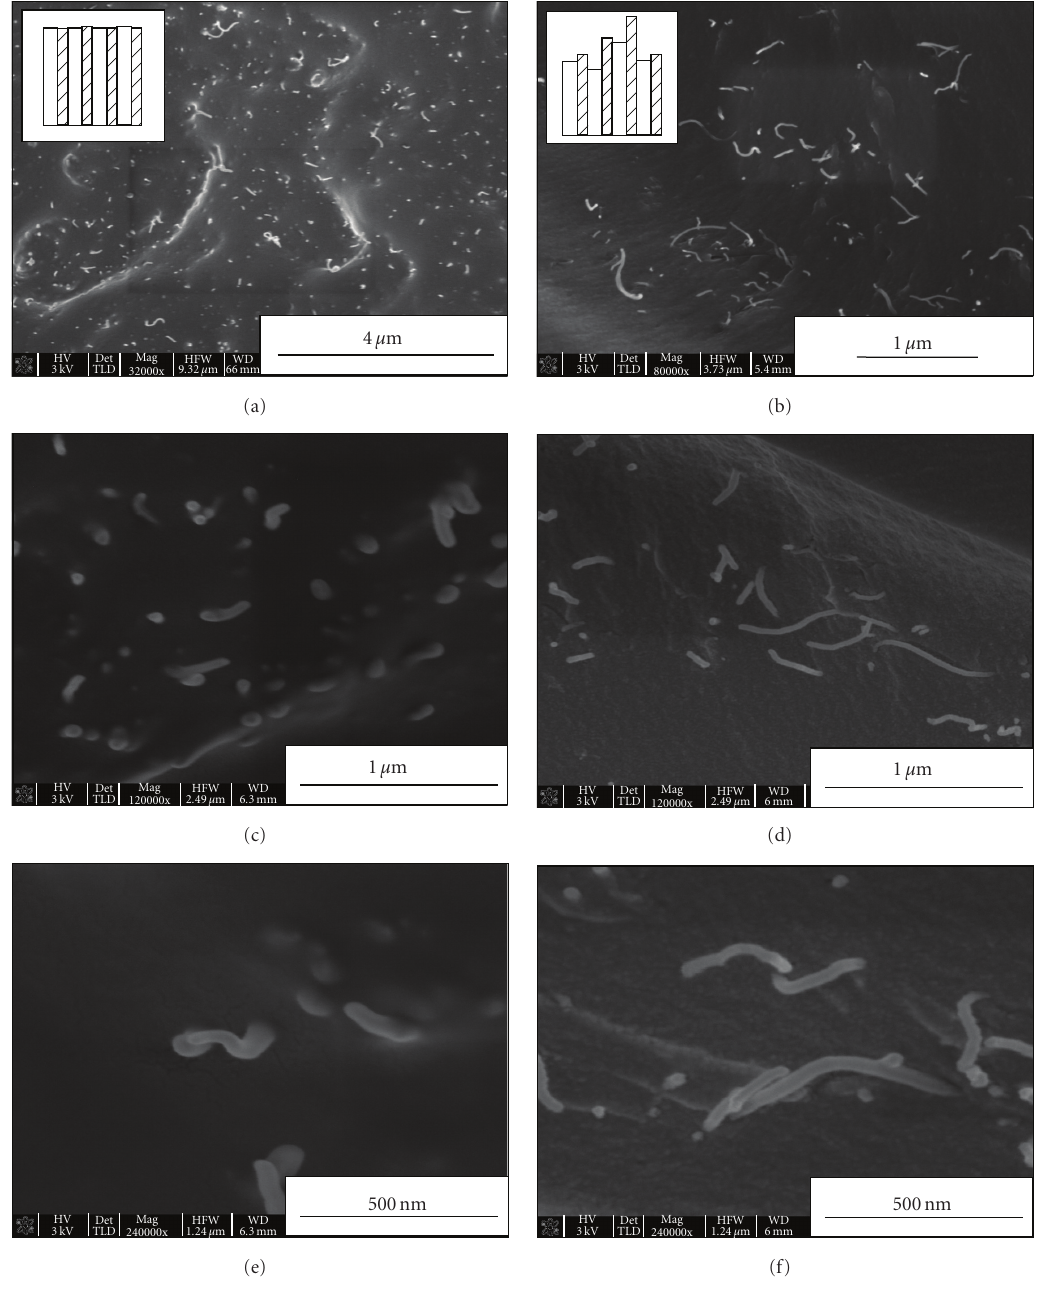
Figure 8: FEG-SEM micrographs of nanocomposites reinforced with 0.25 wt%: precured at 130 ◦ C for 1 hour (a, b, c) and nonprecured (d, e, f). Schemes of fracture modes inside Figures 8(a) and